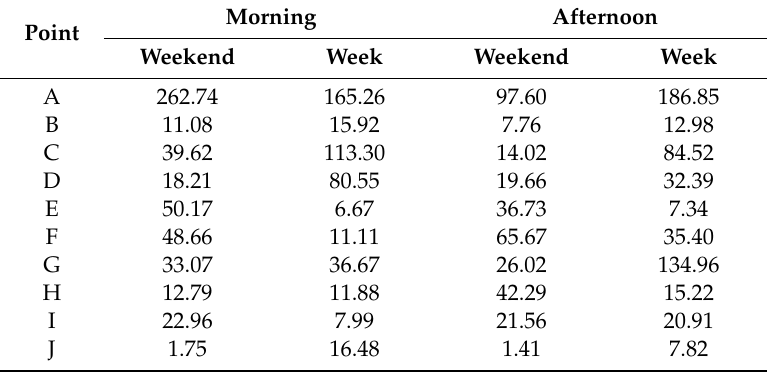
Table 5. Measures recorded around the university area German Jordanian University. (GJU, points A to J), values expressed in µ W / m 2 .